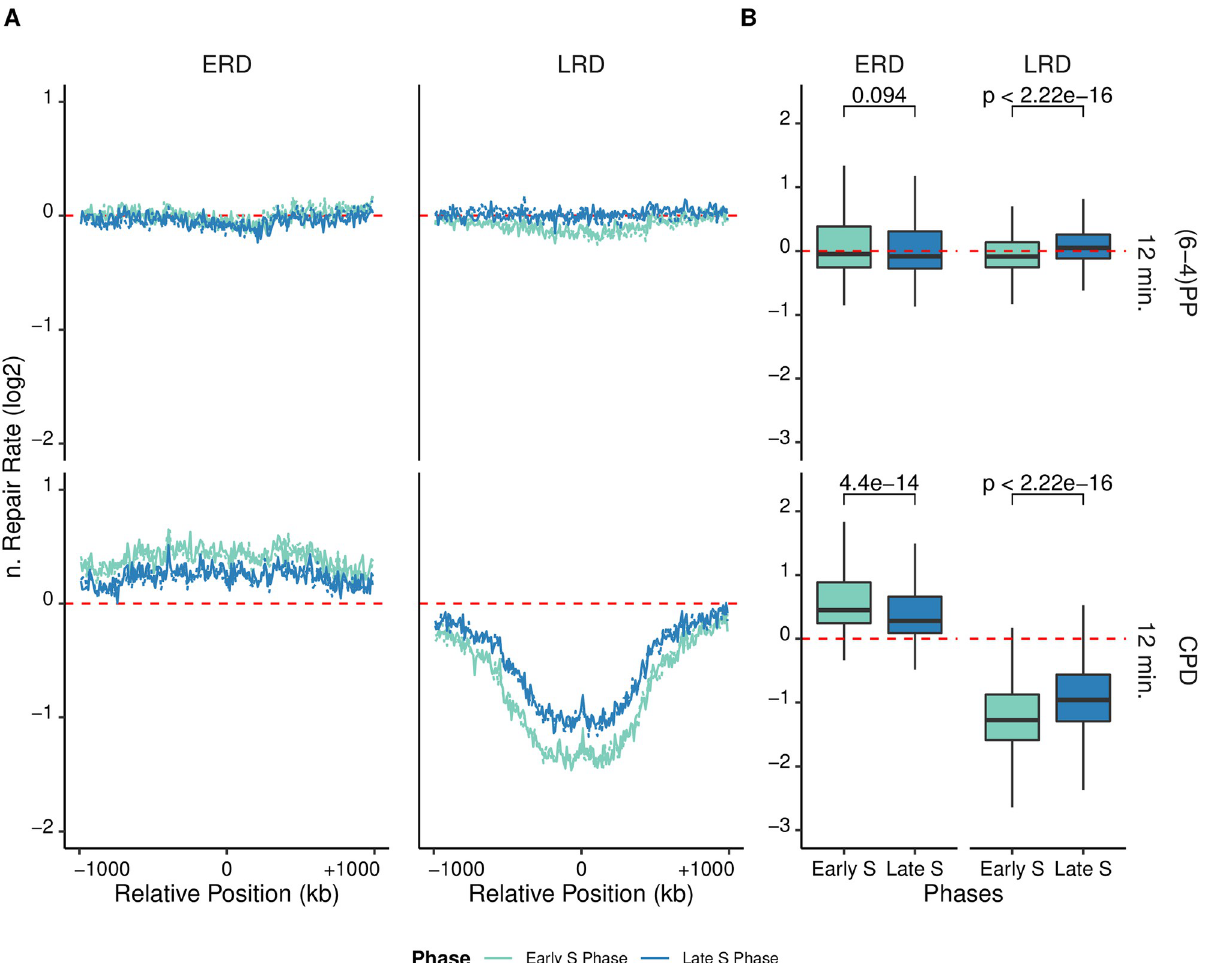
Fig 2. The shift of repair rates with replication timing. (A) normalized Repair rates [log2 (XR-seq real/simulation /Damage-seq real/simulation )] of (6–4)PPs (Top) and CPDs (Bottom) around the center of ERDs (left, n = 118) and LRDs (right, n = 237). Dashed lines were the plus strands and straight lines were the minus strands. (B) Boxplot of normalized repair rates of (6–4)PPs and CPDs for both ERDs (left, n = 266) and LRDs (right, n = 541). The wilcoxon test was used to assess the significance of differences between early and late S phases. Replicate A and B are